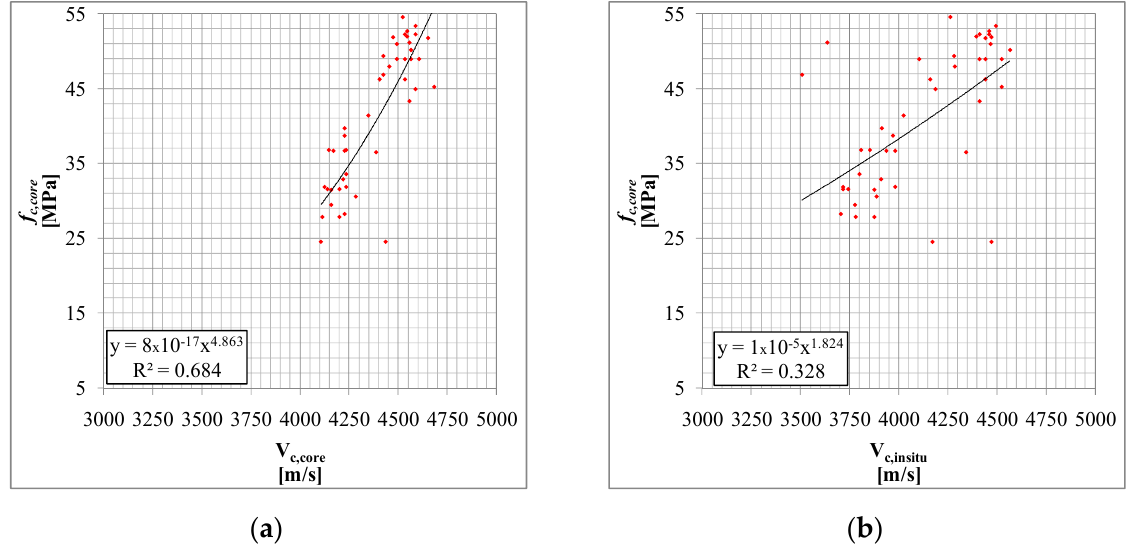
y = 8 x 10 -17 x 4.863 R² = 0.684